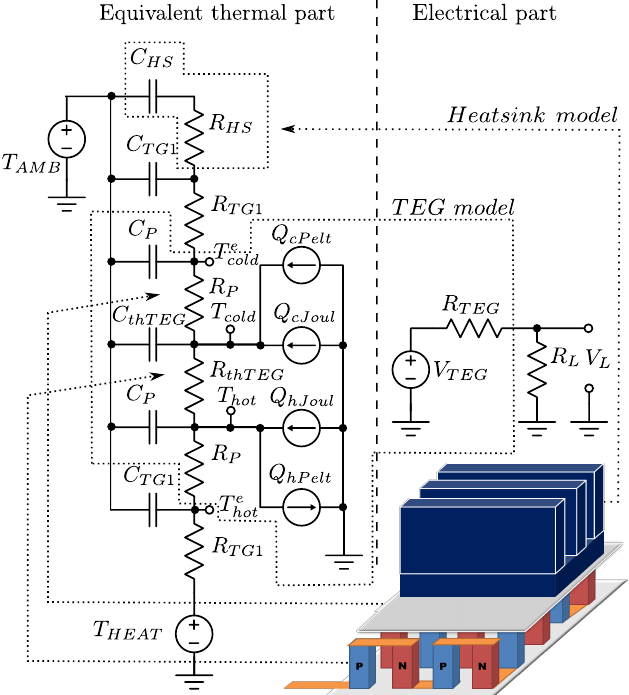
Figure 2. Elements of the equivalent electro-thermal model of the TEG with heatsink.